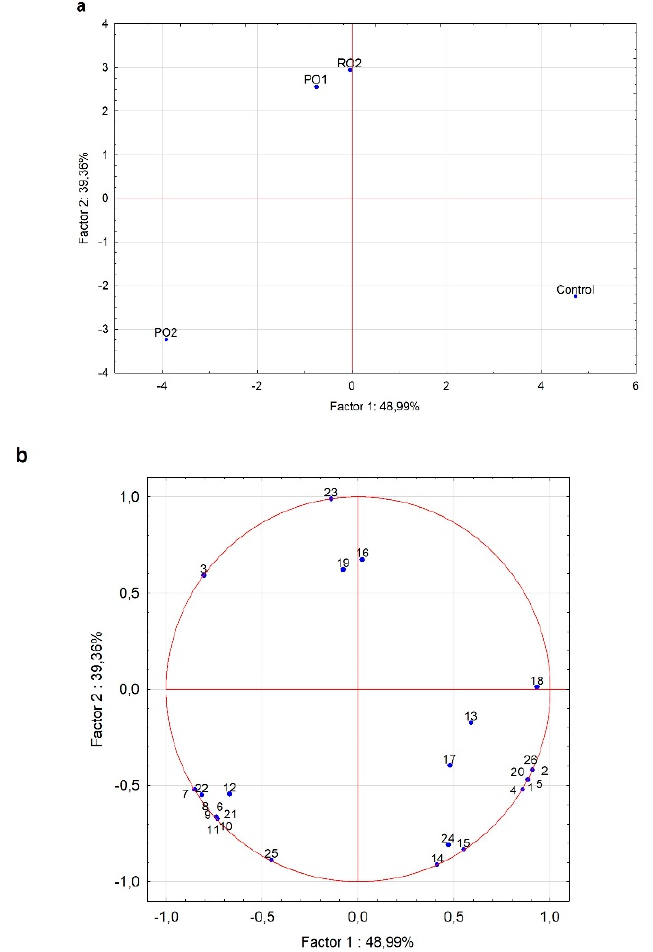
Figure 5. Projection on the factor plane (1 × 2) of ricotta whey inoculated with three different strains of Y. lipolytica (RO2, PO1, PO2) and incubated for 72 h. The control was represented by caciotta whey without Y. lipolytica . ( a ) Treatments; ( b ) Variables. 1: hexanoic acid, ethyl ester; 2: ethyl acetate; 3: